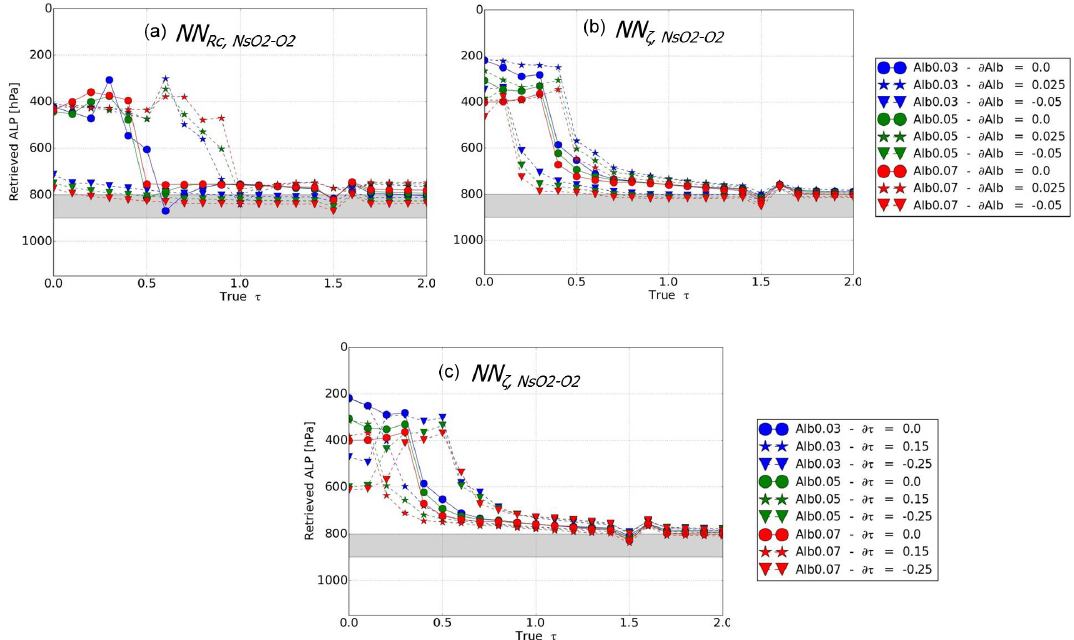
Figure 8. Simulated ALP retrievals, based on noise-free synthetic spectra with aerosols, as a function of true τ . The retrievals are achieved with the NN configurations (NN R and/or NN τ,N s ; see Sect. 3.1) trained with ω 0 = 0.95. The assumed geophysical conditions c ,N s O2 − O2 O2 − O2 are temperature, H 2 O, O 3 and NO 2 from climatology mid-latitude summer, θ 0 = 25 ◦ , θ = 25 ◦ and P s = 1010hPa. The reference aerosol scenario assumes fine scattering particles ( α = 1.5, ω 0 = 0.95, g = 0.7) located between 800 and 900hPa: (a) and (b) sensitivity of ALP retrievals to a surface albedo bias ( ∂Alb = 0.0, 0.025, − 0.05) with NN R and NN τ,N s ; (c) sensitivity of ALP retrievals to a c ,N s O2 − O2 O2 − O2